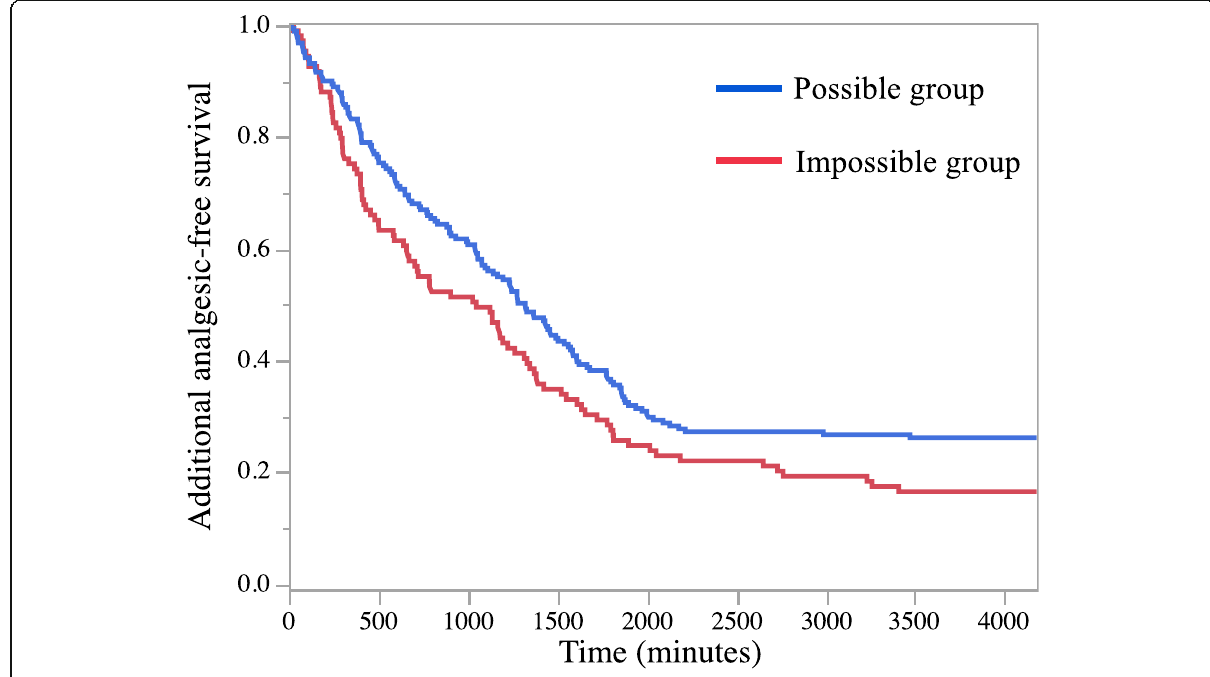
Fig. 2 Kaplan – Meier curves for analgesic-free survival after surgery for both